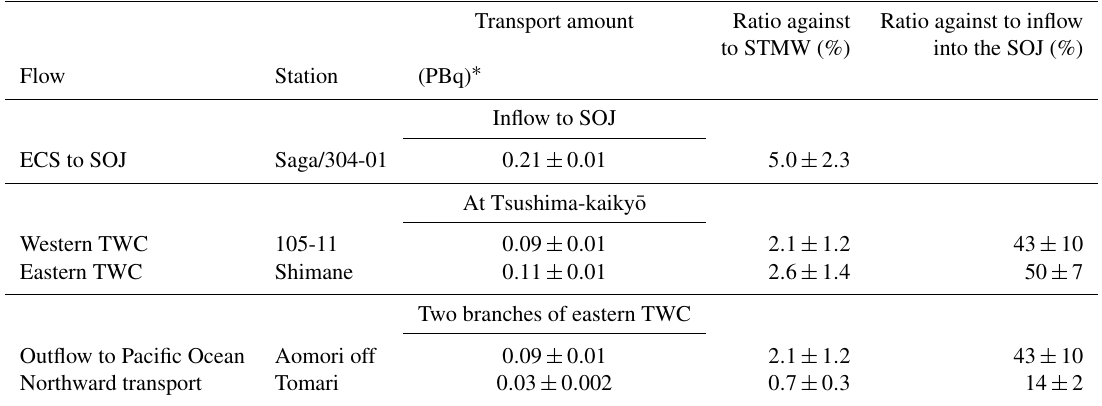
Table 1. Estimated transport amount of FNPP1-derived 137 Cs in the monitoring site in the SOJ along with the Tsushima Warm Current. Transport amount Ratio against Ratio against to inflow to STMW (%) into the SOJ (%) Flow Station (PBq) ∗ Inflow to SOJ ECS to SOJ